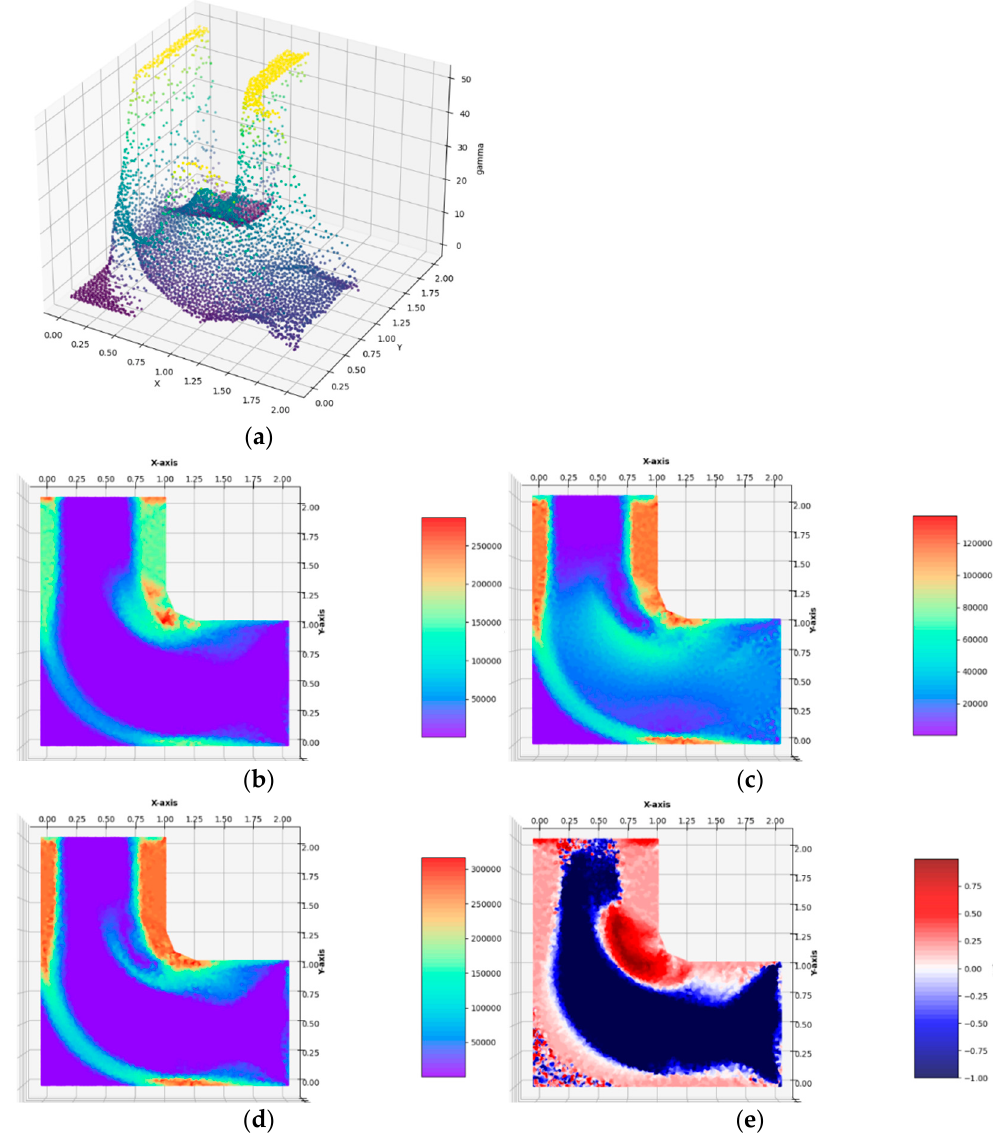
Figure 12. Optimal solutions of the problem of Example 3. ( a ) The plot of the γ function, ( b ) bulk modulus k * / b , ( c ) shear modulus µ * / b , ( d ) Young’s modulus E * / b , ( e ) Poisson’s ratio ν * in the case of FEM mesh composed of triangular elements.